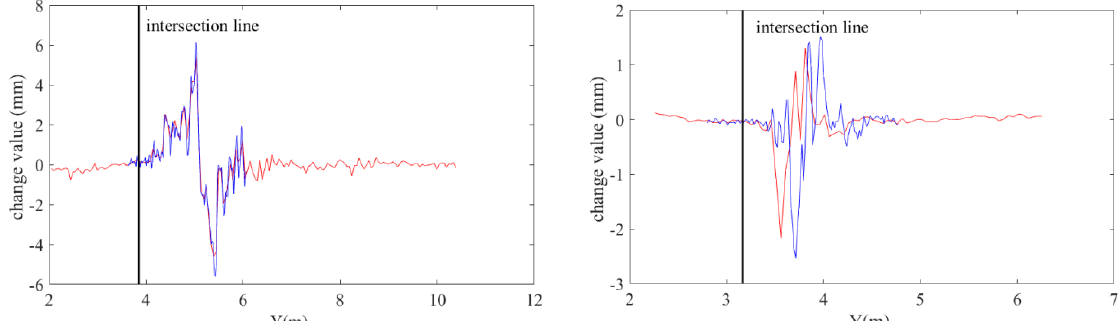
Figure 5. Change profile along the Y axis (left for slope 1 and right for slope 2), i.e. the along flume direction. A change value at a given Y location is obtained by averaging all changes for the corresponding X values. The red line represents the slope change profile for the entire flume obtained with a pixel size of 0.05 m. The blue line is the change profile restricted for the ROI obatined with a smaller pixel size of 0.016 m.